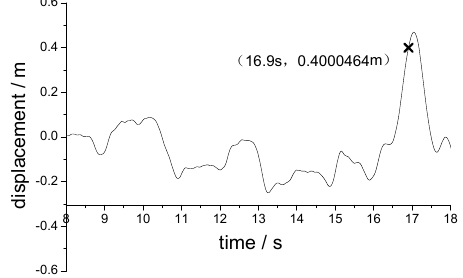
Figure 11. Relative displacement response of side pier and girder.